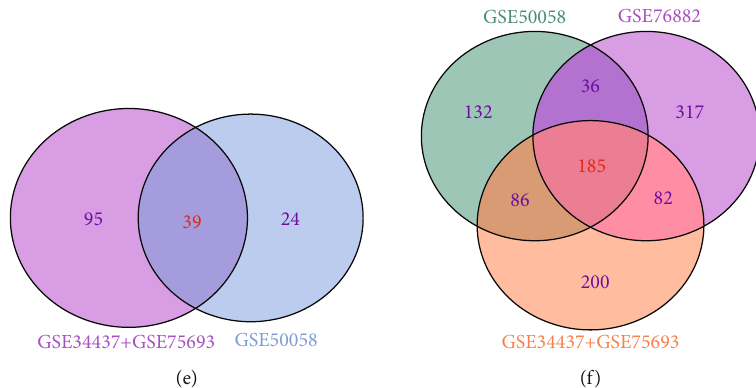
Figure 2: Identi fi cation of DElncRNAs and DEmRNAs (adjusted p value < 0.05 and ∣ log FC ∣ >1 for DEmRNAs). (a, b) Volcano plots of DElncRNAs in the merged dataset and GSE50058 dataset, respectively. (c, d) Heat and ∣ log 2 maps of top 20 DElncRNAs in the merged dataset and GSE50058 dataset, respectively. (e) Venn diagram of 39 common DElncRNAs between the merged dataset and GSE50058 dataset. (f) Venn diagram of 185 common DEmRNAs among the merged dataset, GSE50058 dataset, and GSE76882 dataset (volcano plots and heat maps of DEmRNAs in these three datasets are presented in Figure S2). DElncRNAs: di ff erentially expressed lncRNAs; DEmRNAs: di ff erentially expressed mRNAs; FC: fold